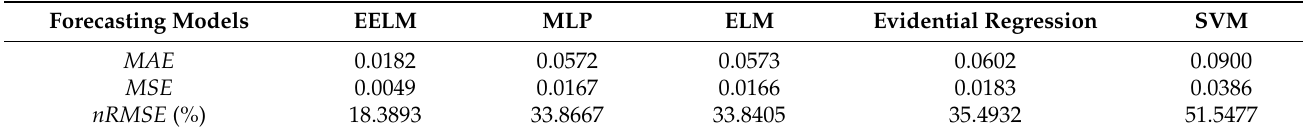
Table 2. Forecasting error of various forecasting algorithms.